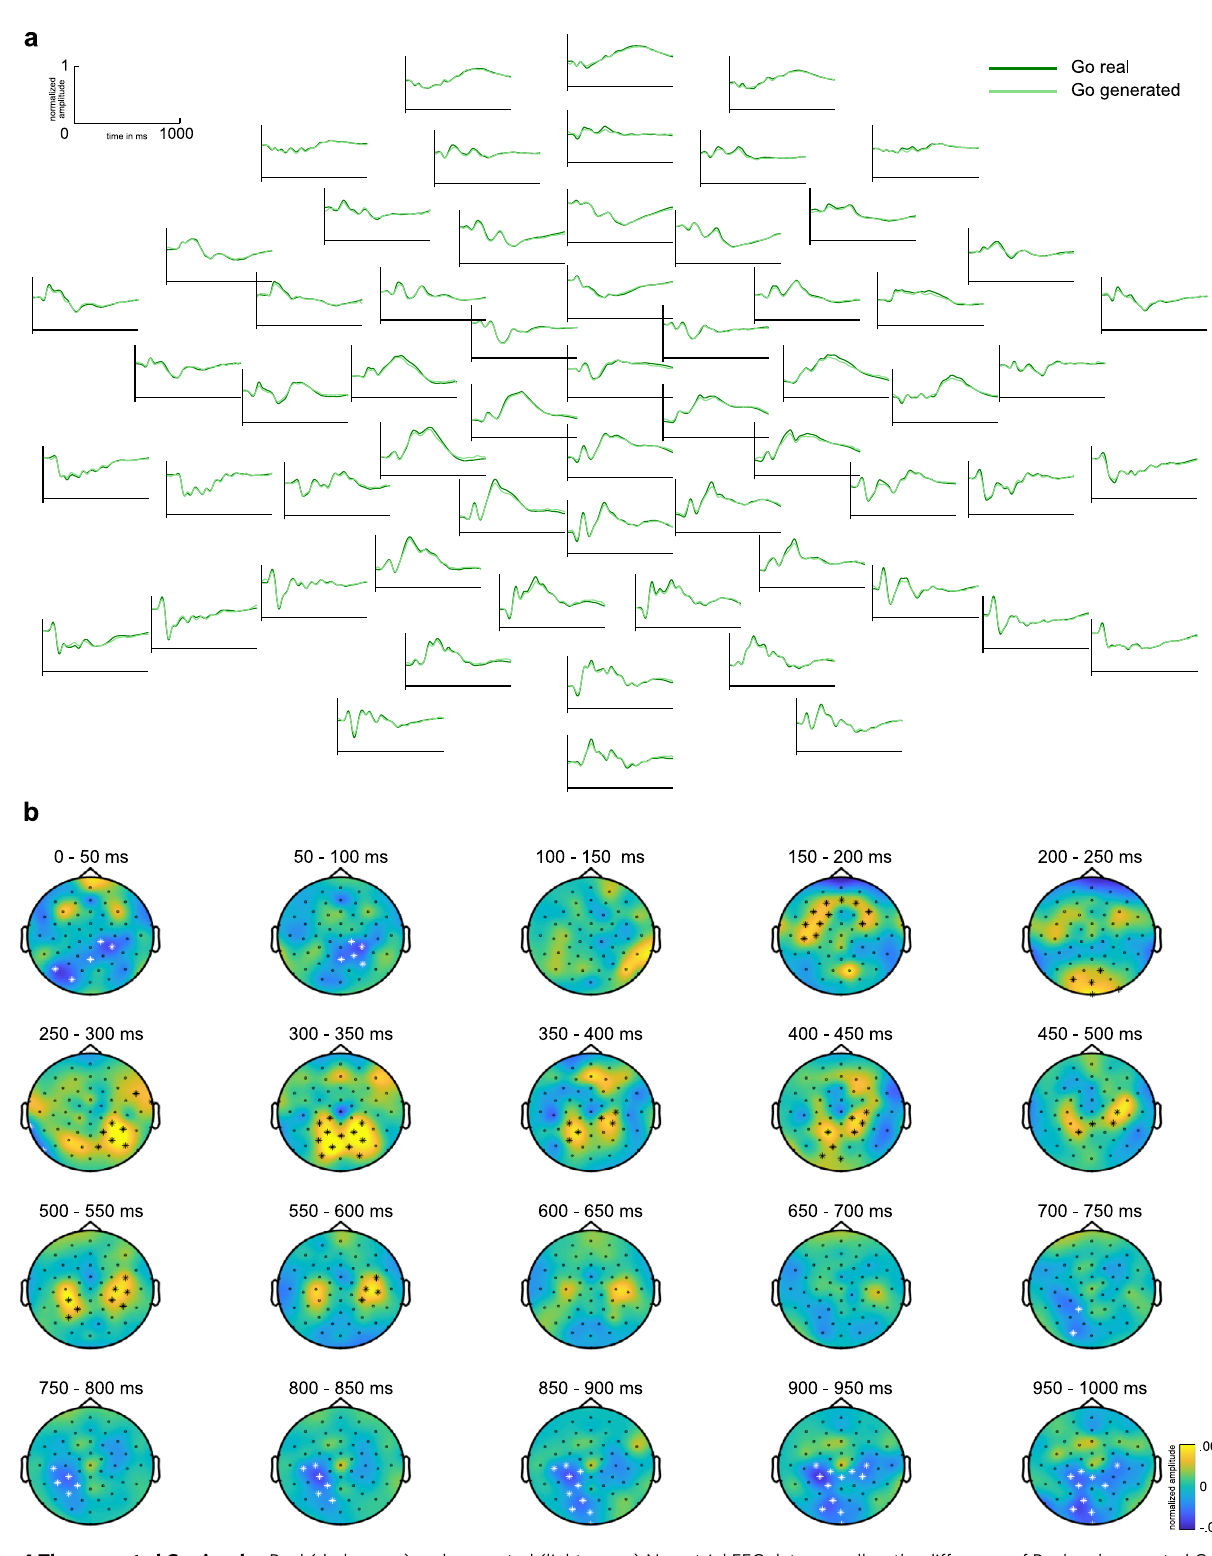
Fig. 4 The generated Go signal. a Real (dark green) and generated (light green) Nogo trial EEG data as well as the difference of Real and generated Go EEG signal (blue). The x -axis denotes time in ms from stimulus onset, y -axis normalized signal amplitude. b Results of cluster-based permutation analysis comparing real and generated Go signal, aggregated in 50 ms steps. Electrodes showing signi fi cant differences in the respective time step are marked by an asterisk, positive differences by a black, and negative differences by a white asterisk. Colors denote amplitude differences. The fi gures show normalized